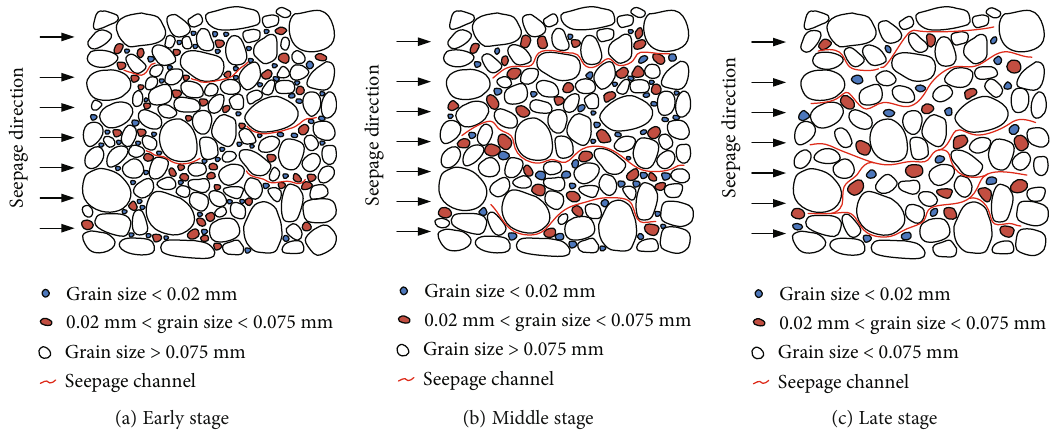
Figure 16: Schematic diagram of the soil seepage